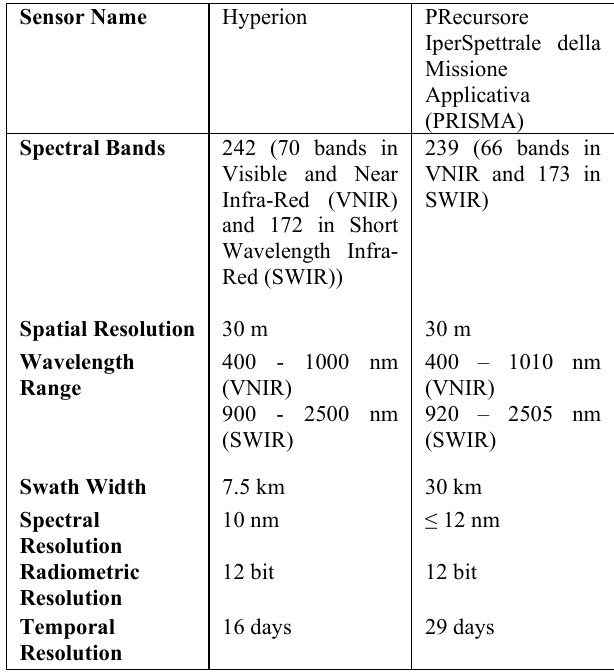
Table 1. HSI Sensor Specifications (Pearlman et al.,